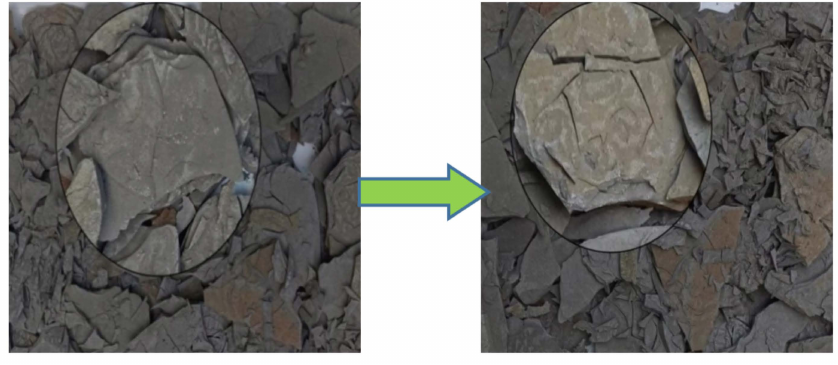
Figure 13. The cracks widened and